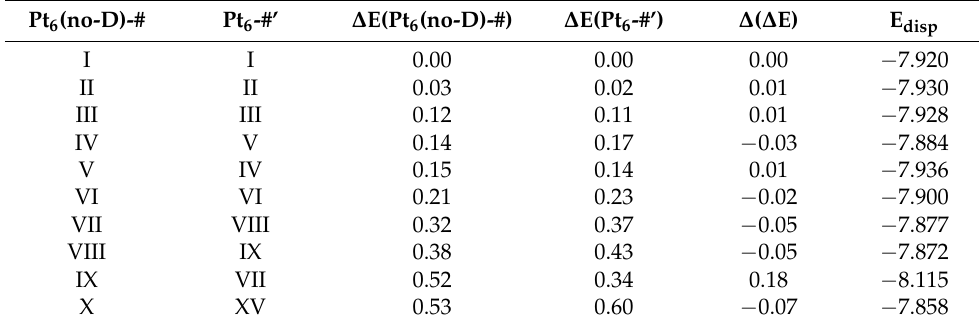
Table 1. Correspondence of the 10 most stable structures obtained from the ensemble without dispersion (Pt 6 (no-D)-#) with those obtained with dispersion corrections (Pt 6 -#’). All energy values are provided in